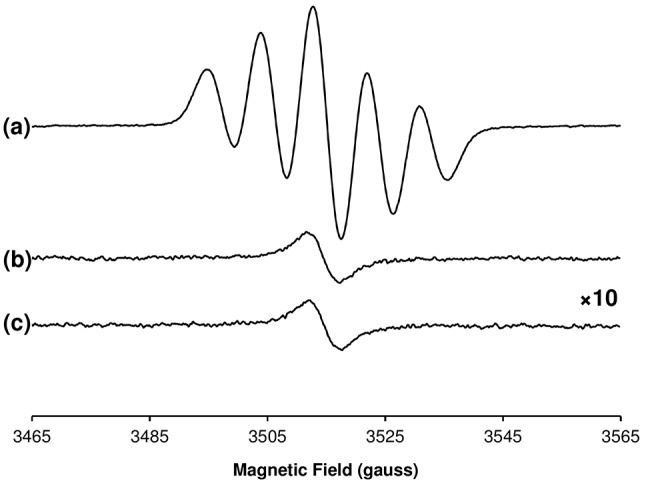
Antiradical activity of brewed coffee does not consume or generate stable coffee radicals.Room-temperature CW-EPR spectra of 1:1 MeOH/water solutions containing (a) 50 μM DPPH• alone, (b) brewed coffee added to an equal volume of 100 μM DPPH• in MeOH, and (c) brewed coffee added to an equal volume of MeOH. Data represent results of assay performed on a single brew. For clarity, the vertical scale is an order of magnitude higher spectra in b and c as compared with a. Experimental conditions: microwave frequency, 9.860 GHz; microwave power, 10 mW; magnetic field modulation amplitude, 4 G; field modulation frequency, 100 kHz; receiver time constant, 82 ms; receiver gain, 70 dB; sweep rate, 4 G/s; averages, (a) 4, (b,c) 40.